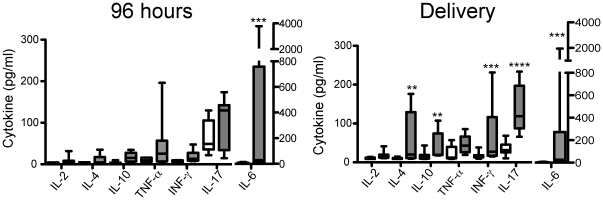
Serum cytokine profiles during pregnancy and UTI.The magnitude of serum cytokines (pg/ml) of cytokines at 96 h (A) and delivery (B) of mothers that received sham infection (white) or experimental UTI (gray). The serum taken from each individual mouse is measured separately. The number of mice used in each cohort at 96 h and delivery were 10 and 8, respectively. Statistical significance was determined using two-tailed Mann-Whitney (**, p<0.04; ***, p<0.008; ****, p = 0.0003).